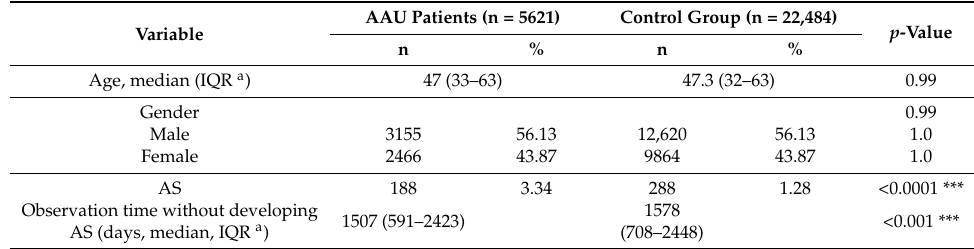
Table 1. Demographics of AAU group and control